Question: What style of plot is this figure drawn as?
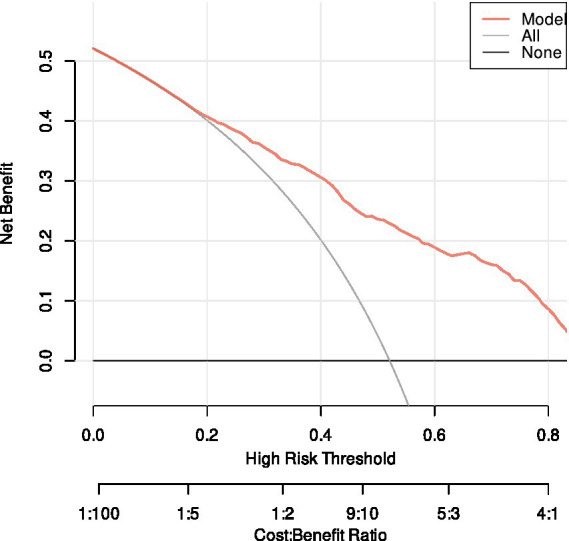
Answer: line